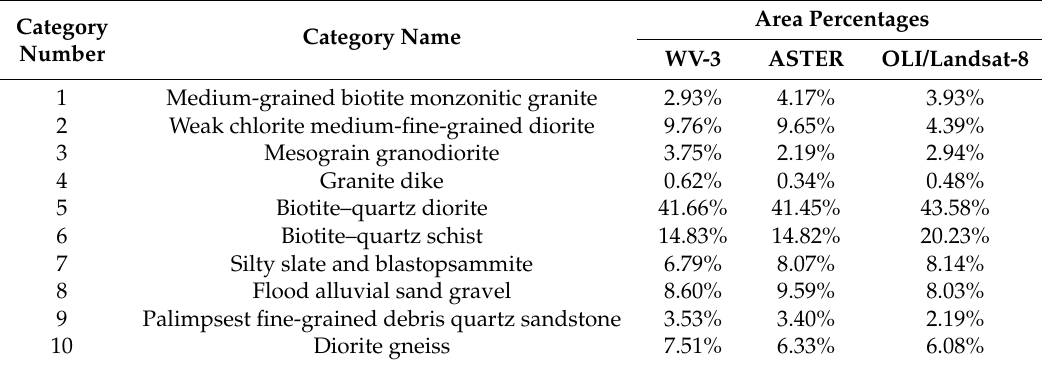
Figure 6. Lithological classification maps after the post-classification processing are shown. ( a ) The lithological classification map of ASTER data; and ( b ) the lithological classification map of OLI/Landsat-8 data. Table 3. The statistical table of classification maps based on area percentages of various classes for WV-3, ASTER and OLI/Landsat-8 data.